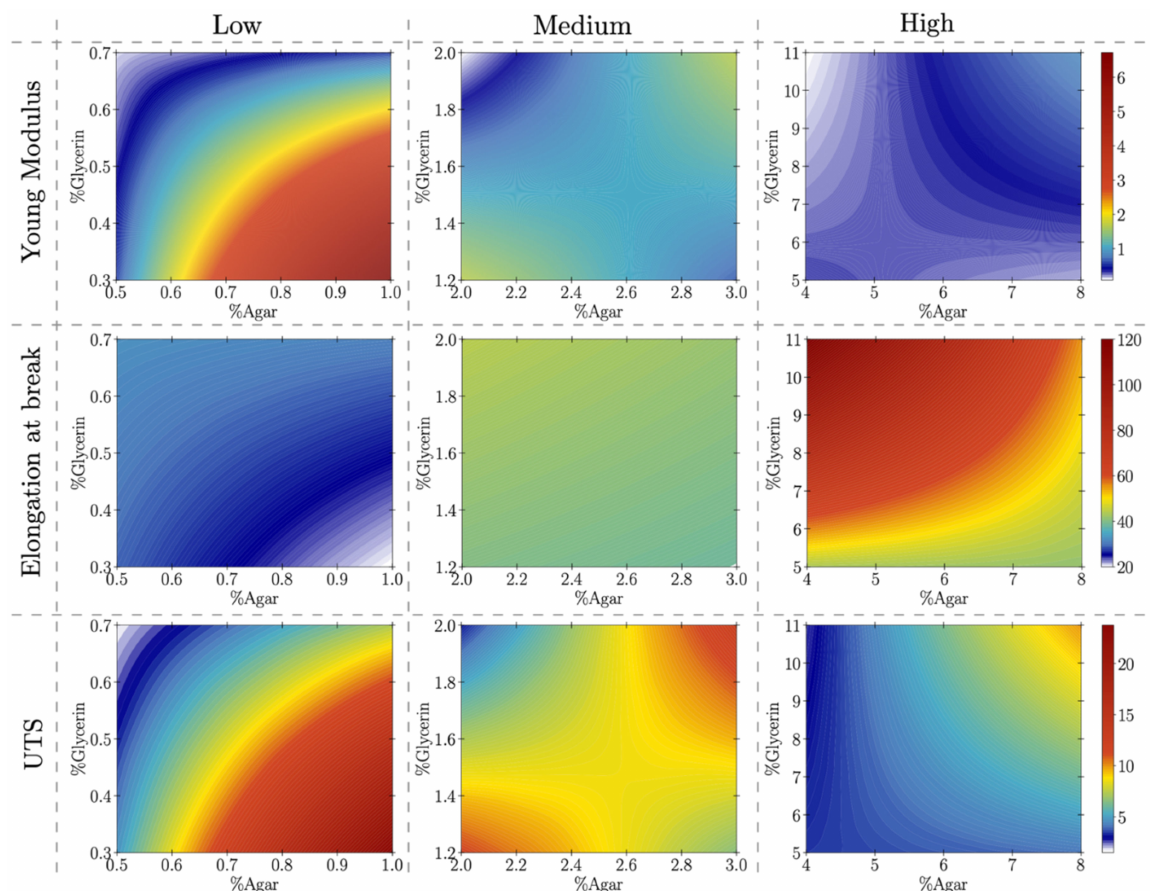
Figure 2. Linear portion of mechanical properties as a function of different concentrations of agar– glycerin percentages. The mechanical properties are the Young’s modulus ( left column ), elongation at break ( mid column ) and ultimate tensile strength ( right column ) for low ( top row ), medium ( mid row ) and high ( bottom row ) agar and glycerin concentrations. The regression coefficients for mechanical properties [Equation (S1)] are given in Supplementary